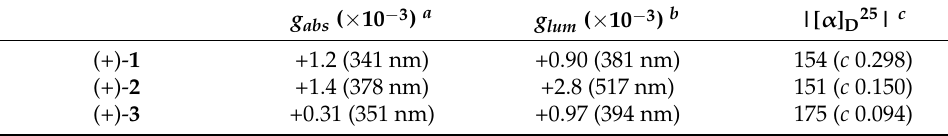
Table 2. Chiroptical date of spiro-fused PACs 1 – 3 in CH 2 Cl 2